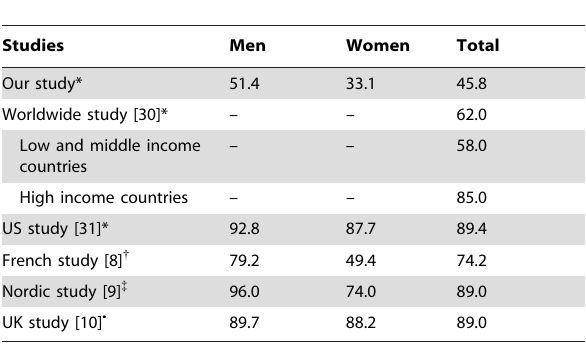
Table 4. Comparison of the population attributable fraction (PAF, %) of esophageal cancer deaths or new cases attributable to the combined effects of smoking, drinking, low vegetable and fruit intake, overweight/obesity, ionizing radiation and occupation in various